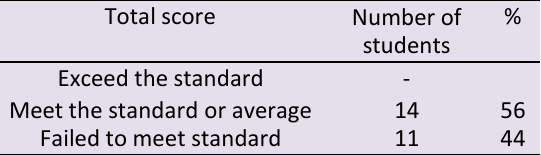
Table 3 . Analysis of Oral Communication Skills